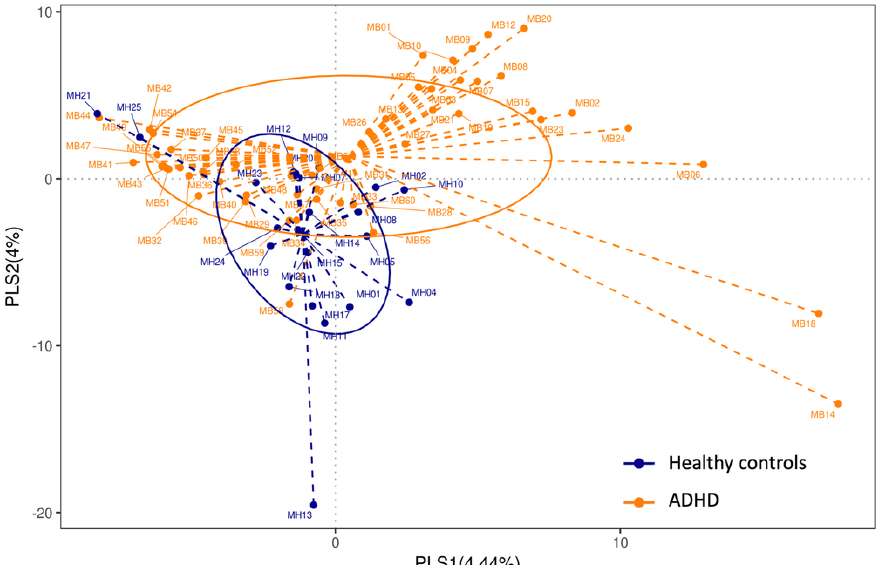
Figure 3. PLS − DA. Partial Least Squares Discriminant Analysis (PLS − DA) of ADHD children with treatment-naïve and healthy controls. Each point represents a sample. The orange points represent ADHD children with treatment-naïve and the blue points represent healthy controls.